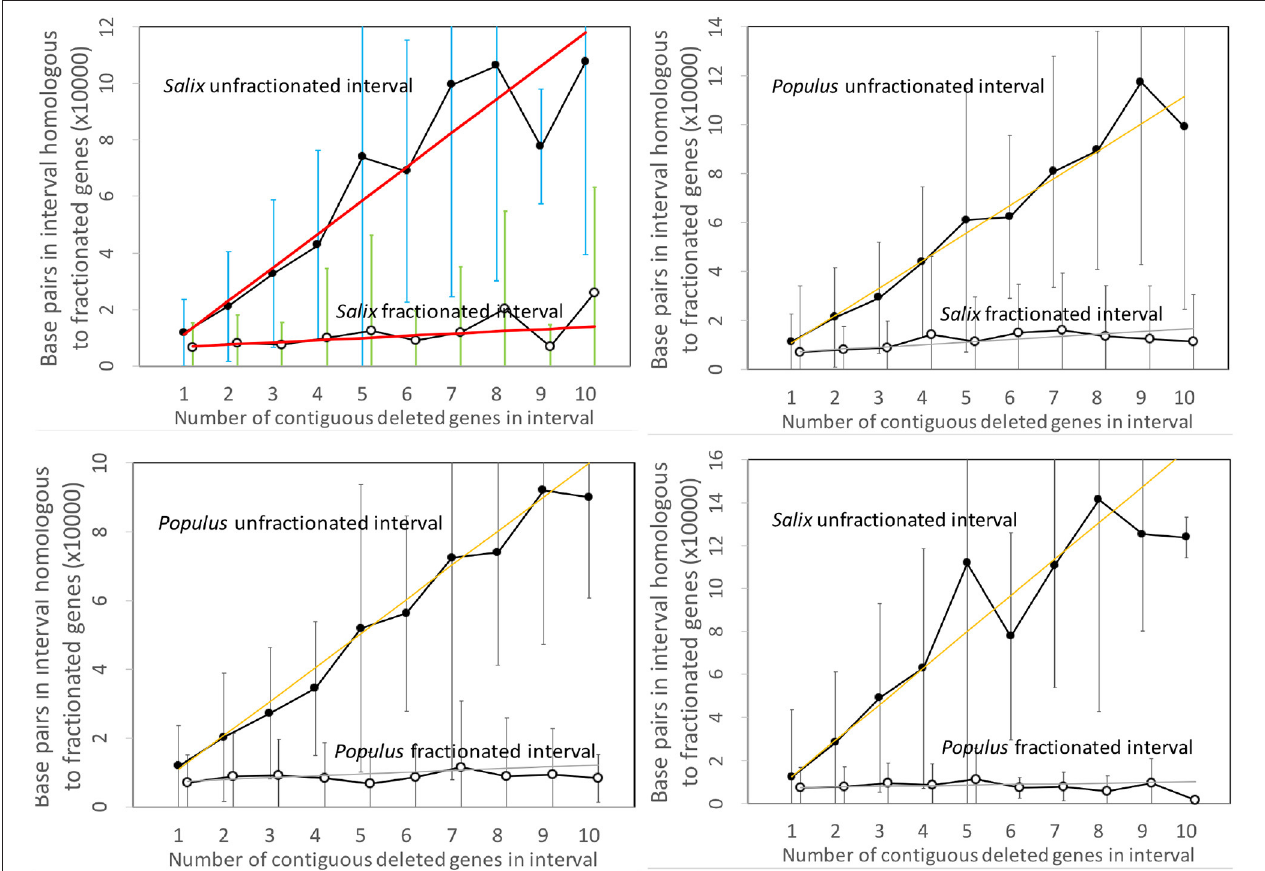
FIGURE 3 | Comparison of DNA content in unfractionated and fractionated intervals in the Salix and Populus genomes. Linear regression fits are indicated. Self-comparisons on the left do not distinguish between subgenomes since these are hard to identify across chromosomes and are generally mingled due to interchromosomal rearrangements, such as reciprocal translocation and chromosome fission and fusion. The two comparisons between genomes on the right hand side analyze gene loss from each genome separately. We use the terms “fractionated” and “unfractionated” in these two panels to mean “reduced” and “conserved,” even though the polyploidization-induced fractionation does not play a role